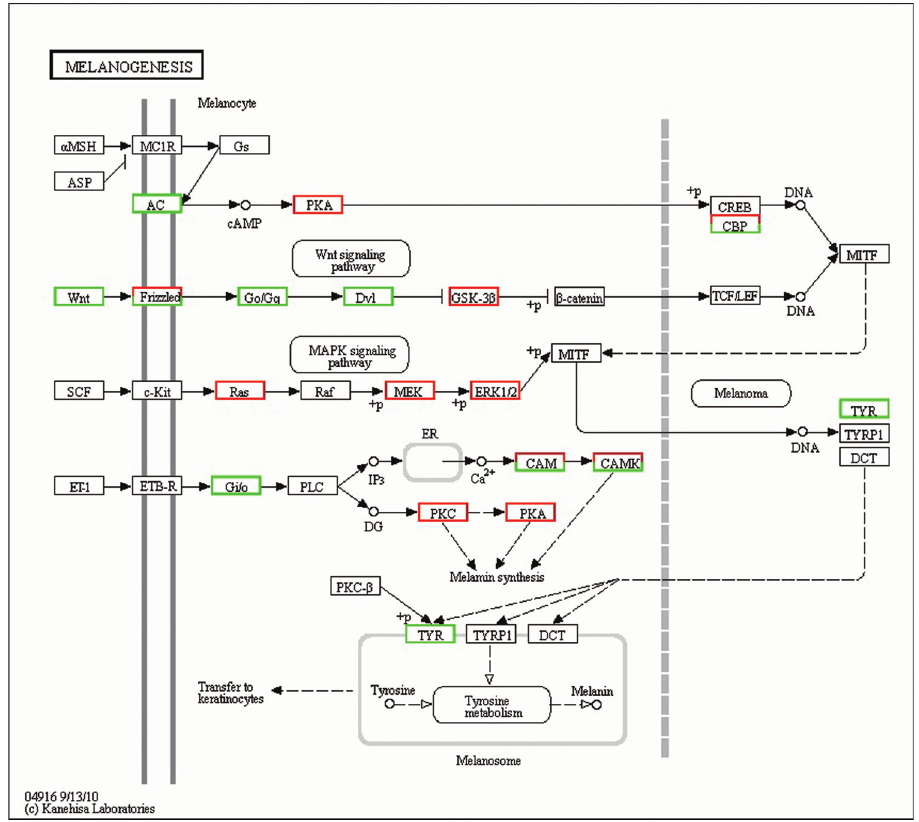
Figure 6 - Significant differentially expressed genes (DEGs) identified by KEGG involved in the melanogenesis signaling pathway. Red boxes indicate significantly increased expression, green boxes indicate significantly decreased expression, and black boxes indicate unchanged